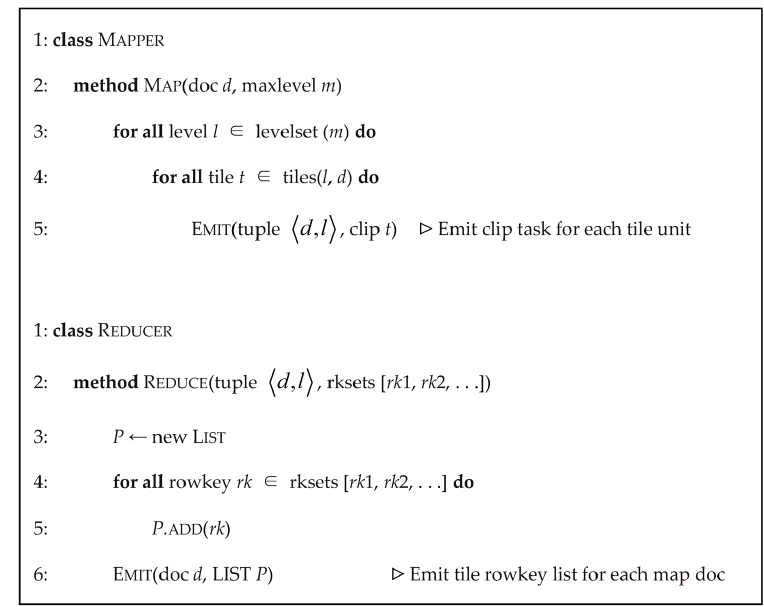
Figure 10. Pseudo-code for the static tile-clip algorithm in MapReduce.